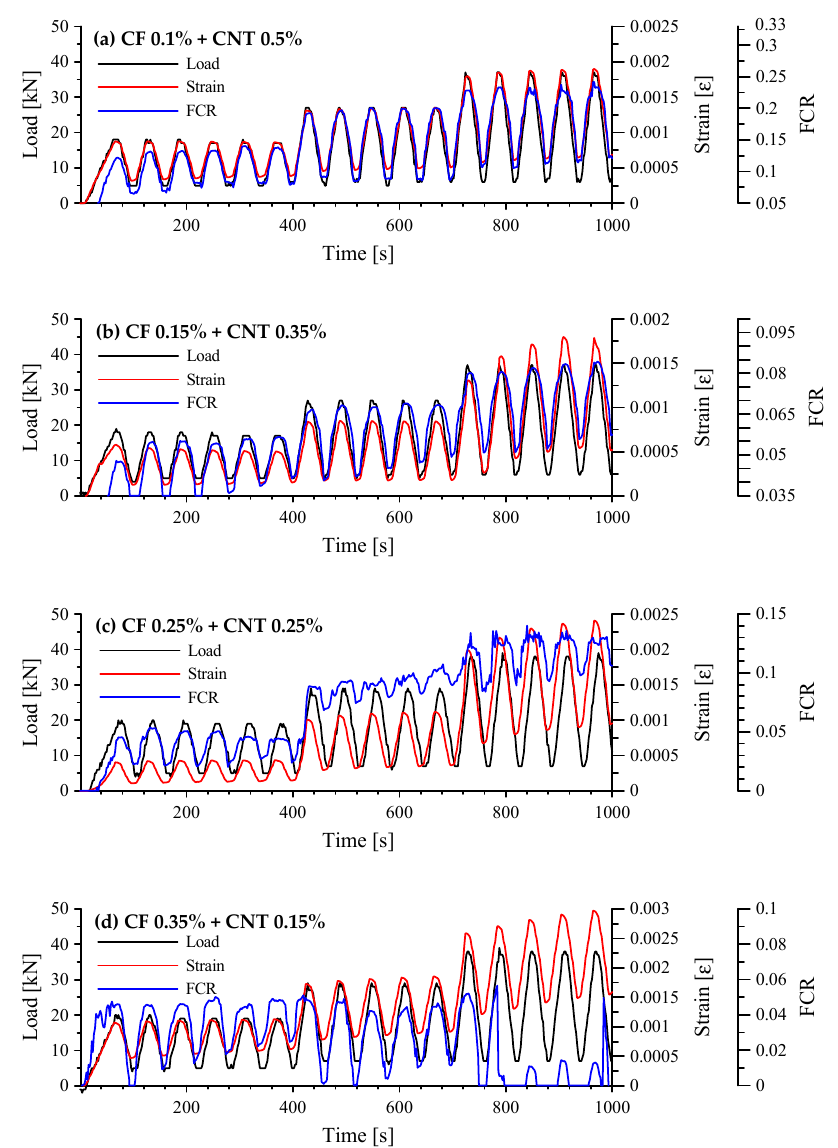
Figure 13. Responses of cement-based composites with both CFs and MWCNTs under cyclic compression; ( a ) composites with 0.1 vol.% CFs and 0.5 vol.% MWCNTs; ( b ) composites with 0.15 vol.% CFs and 0.35 vol.% MWCNTs; ( c ) composites with 0.25 vol.% CFs and 0.25 vol.% MWCNTs; and ( d ) composites with 0.35 vol.% CFs and 0.15 vol.% MWCNTs.